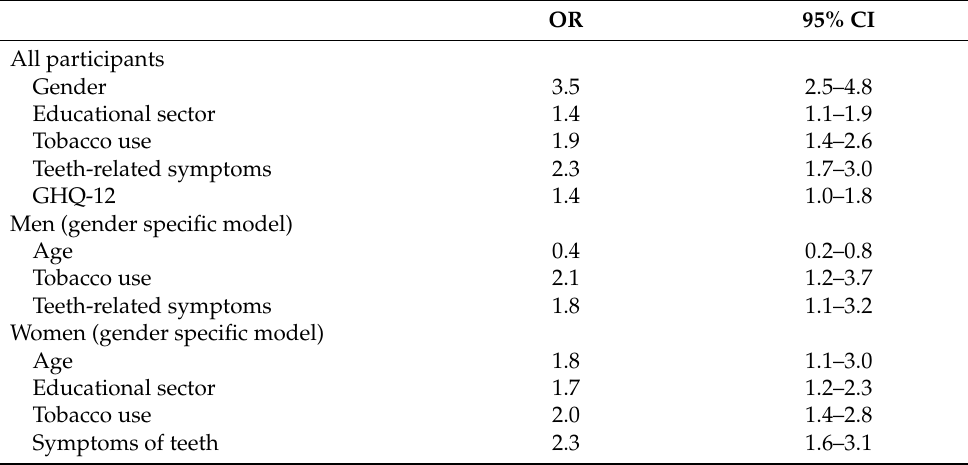
Table 5. Results of logistic regression analyses including GHQ-12 as a measure of psychological distress, dental fear as a dependent variable (not at all or somewhat afraid = 0, very afraid =